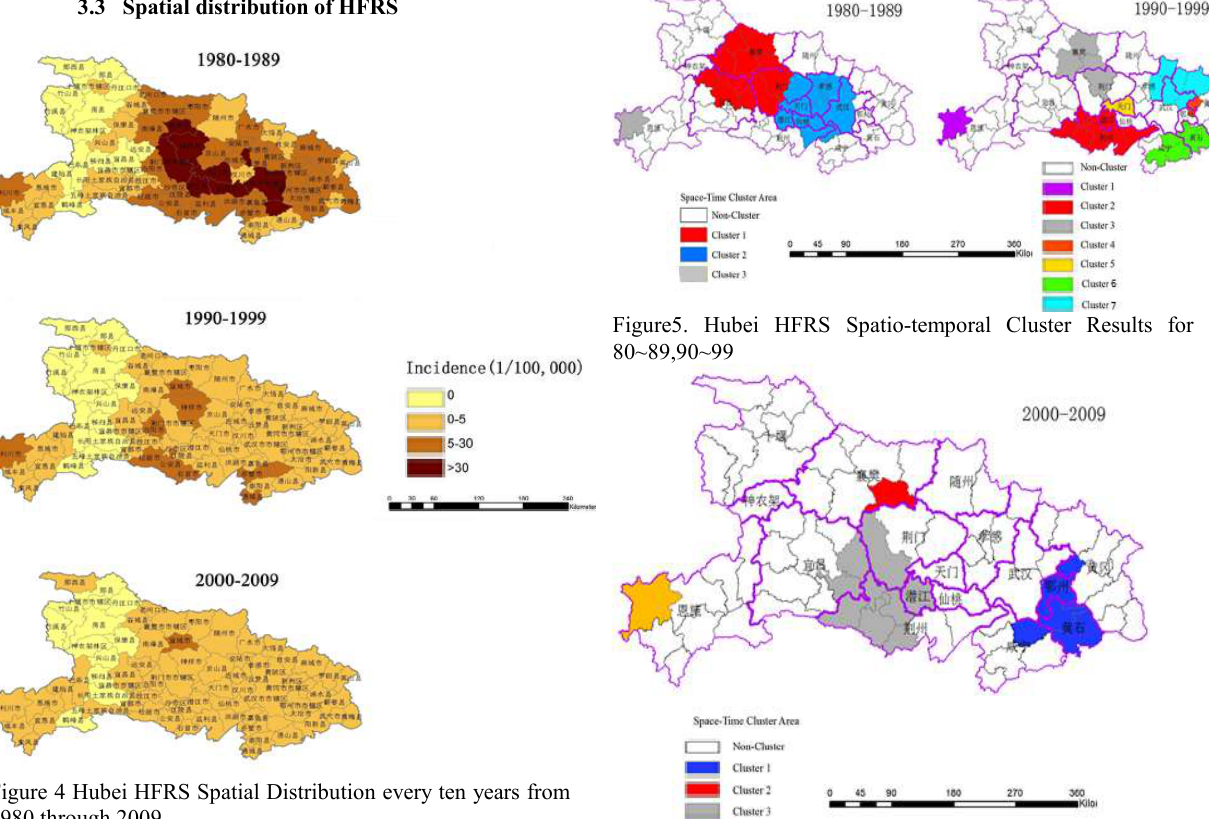
Figure5. Hubei HFRS Spatio-temporal Cluster Results for